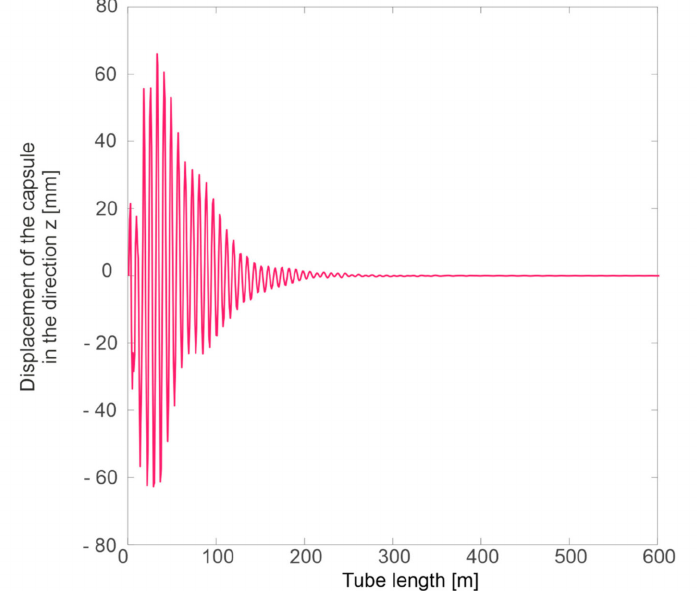
Figure 15. Lateral displacement in the direction from the capsule at a speed of 2000 km /